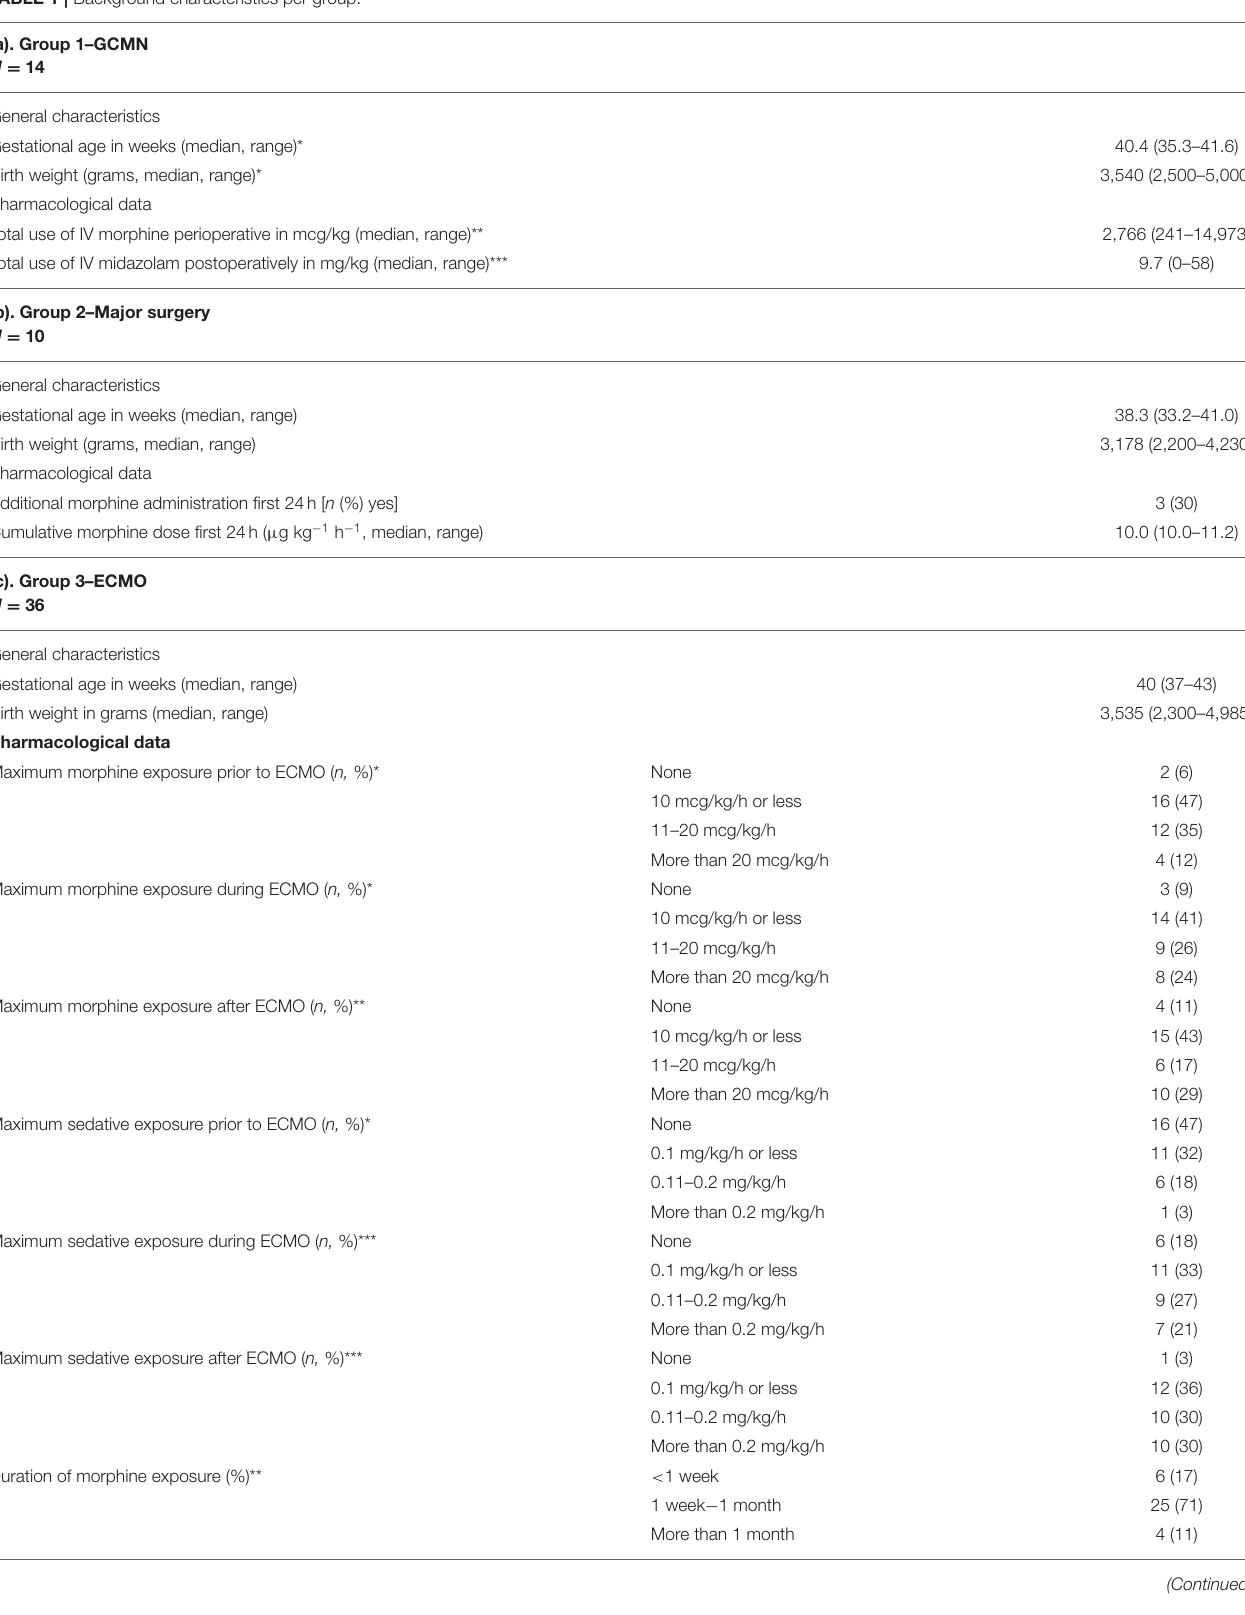
TABLE 1 | Background characteristics per